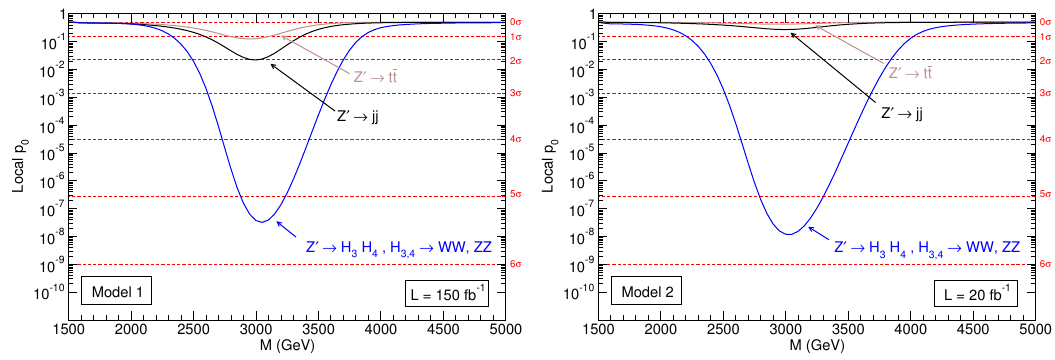
Figure 9 . Expected local p -value for the Z 0 signal in the various searches, for scenario 3 of model 1 (left) and model 2